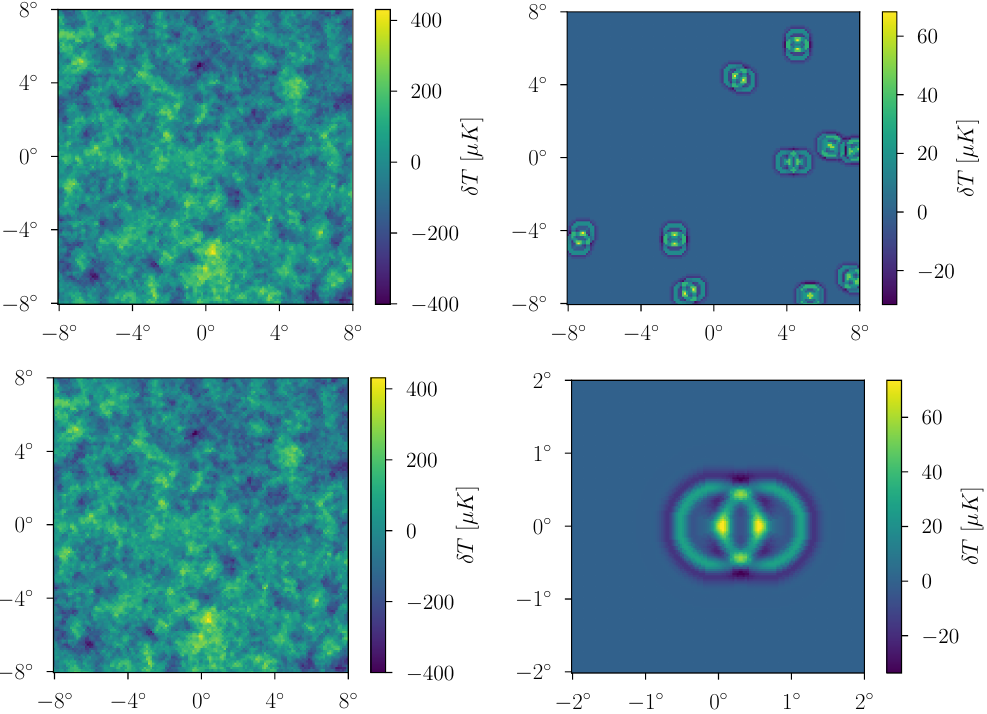
Figure 11 . Local patches of (upper-left) CMB + PHS, (upper-right) PHS, and (lower-left) CMB, generated within a region of longitude = [ − 8 ° , 8 ° ] and latitude = [ − 8 ° , 8 ° ] centered at ( θ, φ ) = ( π/ 2 , 0) and projected onto the Cartesian coordinates ( 140 × 140 pixels) using N = 512 . The side shape of PHS is based on the η = 50 Mpc mode using g = 10 , and the separation distance is ∗ r sep = 0 ∼ 6 pixels. In total, ten PHS signals are injected using a flat distribution. (lower-right) A higher-resolution image of the PHS using N = 2048 side